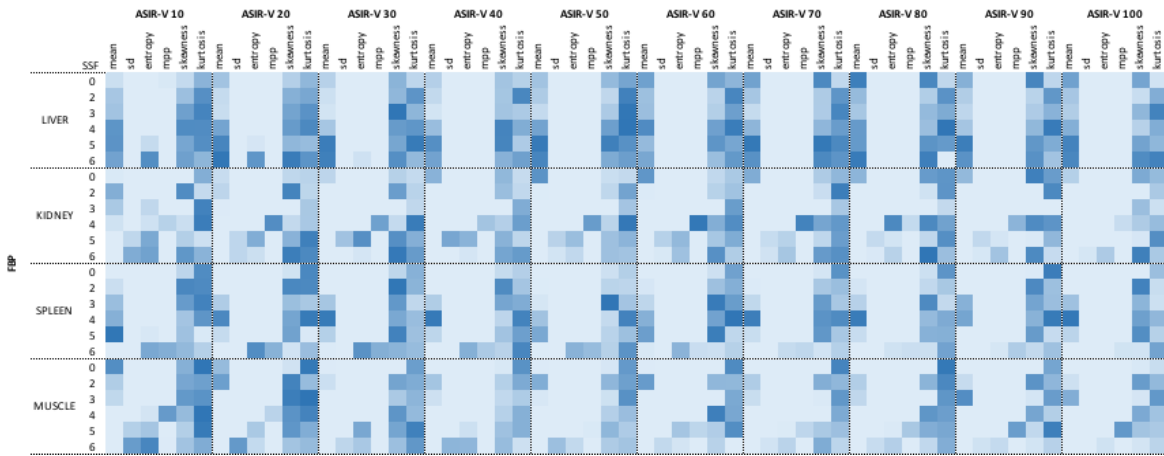
Figure 4. Heat map of filtered analysis. Dark blue boxes show the highest p values; light blue boxes the lowest.